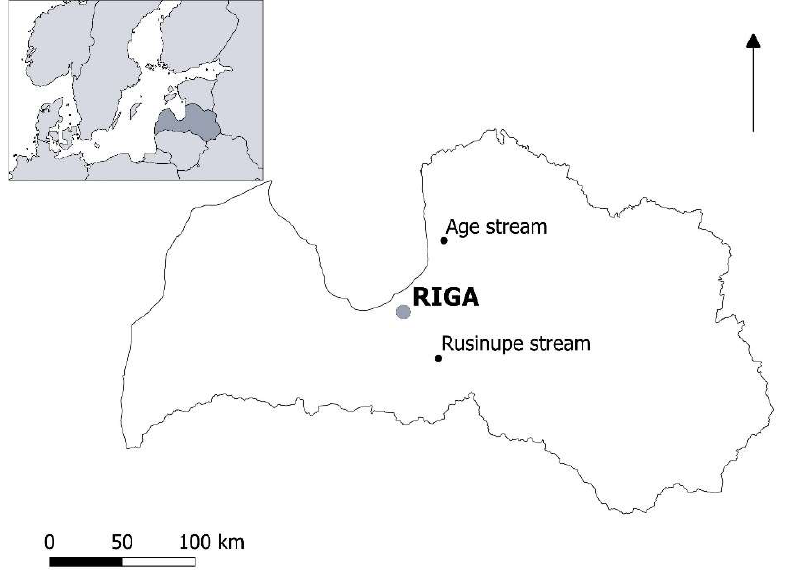
Figure 1. Location of the forest fertilization sites at two hemiboreal streams in Latvia (the boundaries of administrative territories obtained from Eurostat (© EuroGeographics for the administrative boundaries)). Table 1. Characteristics and treatments of the studied forest stands located at two hemiboreal streams in Latvia.